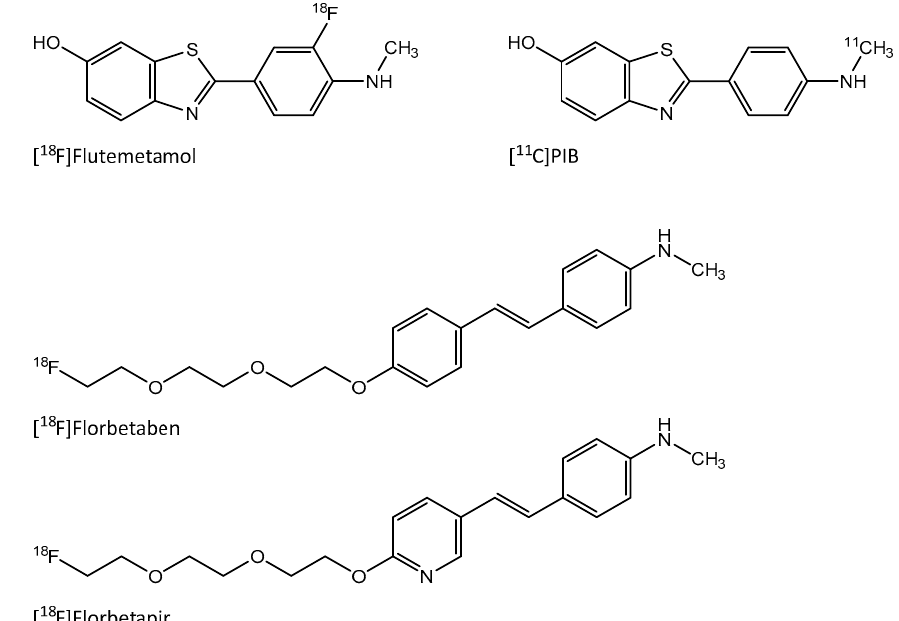
Figure 1. PET tracers targeting amyloid beta. [ 11 C]PIB and [ 18 F]Flutemetamol are benzothiazole derivatives based on the thioflavin-T molecule. [ 18 F]Florbetaben is a derivative of stilbene and [ 18 F]Florbetapir a derivative of styrylpyridine.